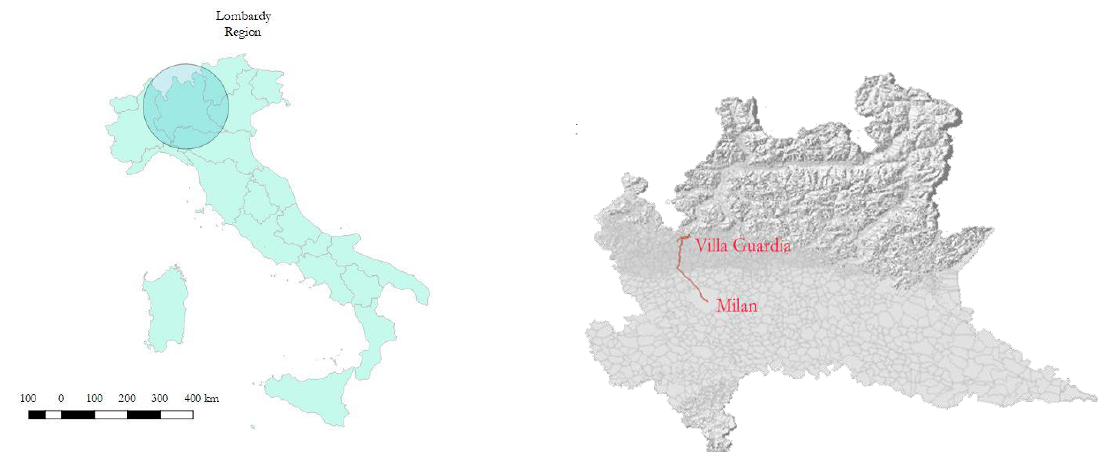
Figure 1. Lombardy region ( left ) and the complete route traveled by the subject from Villa Guardia (45°47′ N 9°01′ E) to the city center of Milan (45°27′ N 9°11′ E) ( right ). Table 1. Summary of the micro-environments (MEs) considered in this study. Hour and time of stay refers to those a priori planned, even if small variations should be considered. (LT: low-traffic condition; HT: high-traffic condition; n.a.: not available). * Return trip—these MEs refer to the same MEs frequented during the first part of the